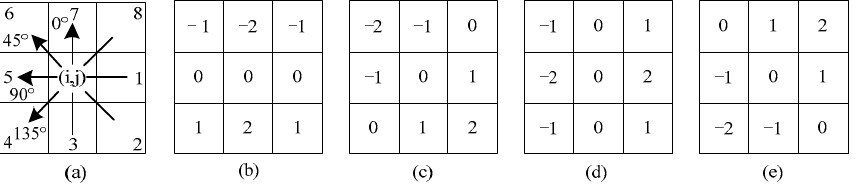
Figure 6. Gaussian distribution and subintervals of gradient directions.